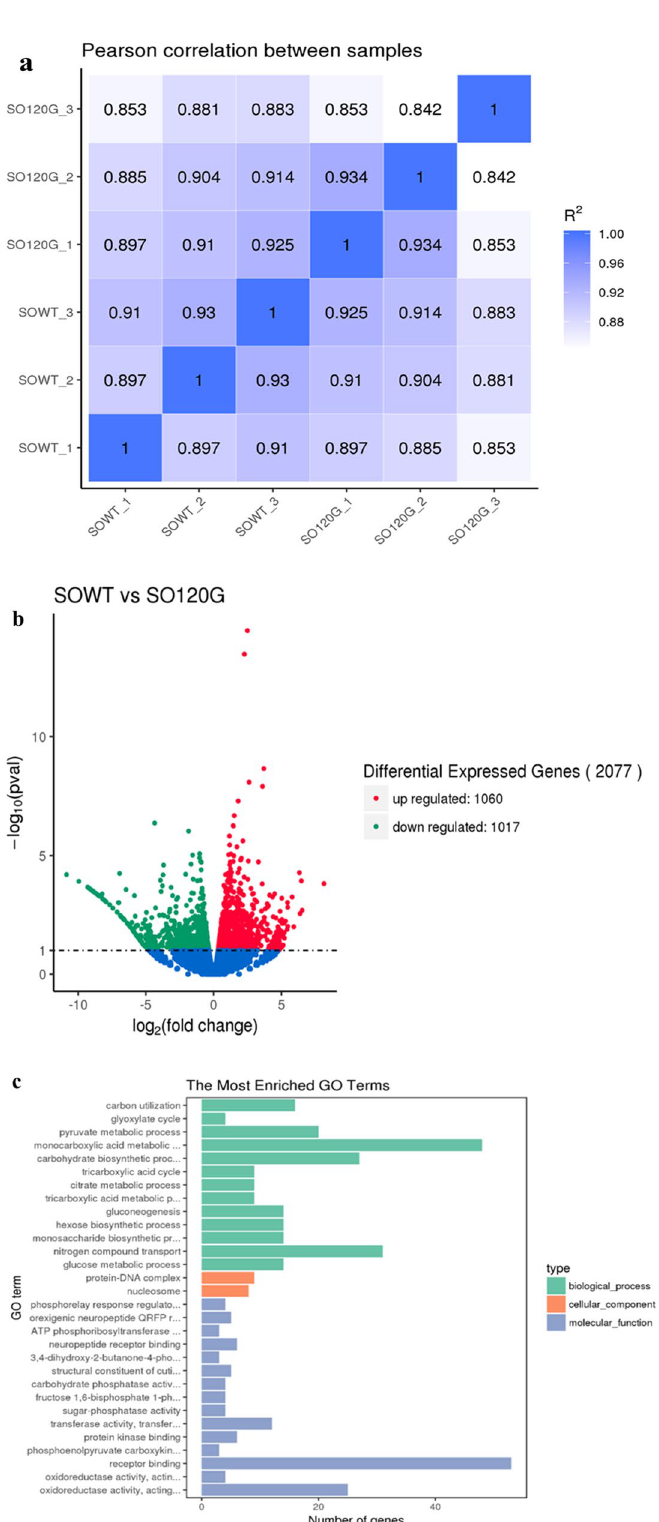
Figure 4. ( a ) Correlation plot between the different samples. The control group (SOWT-1, SOWT-2, and SOWT-3), experimental group (SO120G-1, SO120G-2, and SO120G-3); ( b ) the MA plot of the differentially expressed genes (DE genes). Significantly up-regulated and down-regulated genes are shown as red and green dots, respectively. Genes with no significant changes are shown as black spots; ( c ) gene ontology (GO) classification analysis of all of the genes and DE genes. The X-axis shows the number of genes, the left Y-axis shows the GO